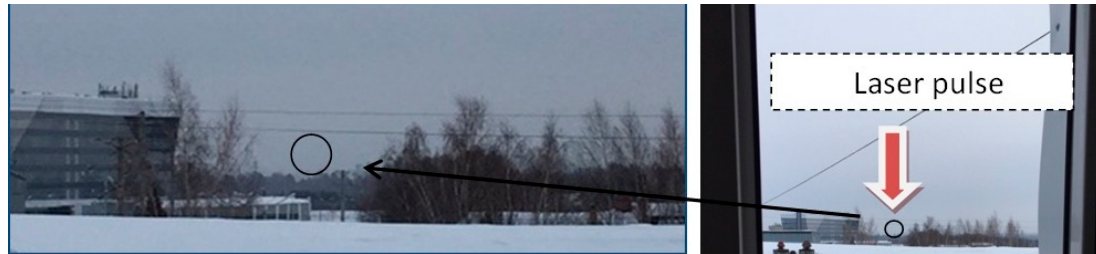
Figure 6. Experimental geometry.